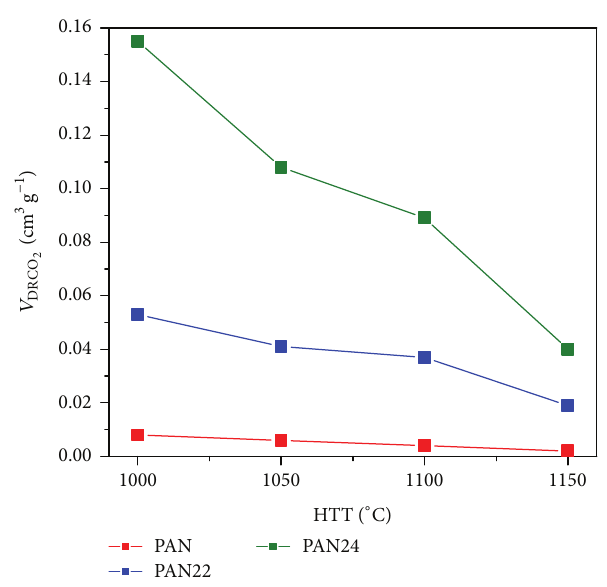
Figure 5: Effect of HTT on the ultramicropore volume 𝑉 carbons from pristine and oxidized